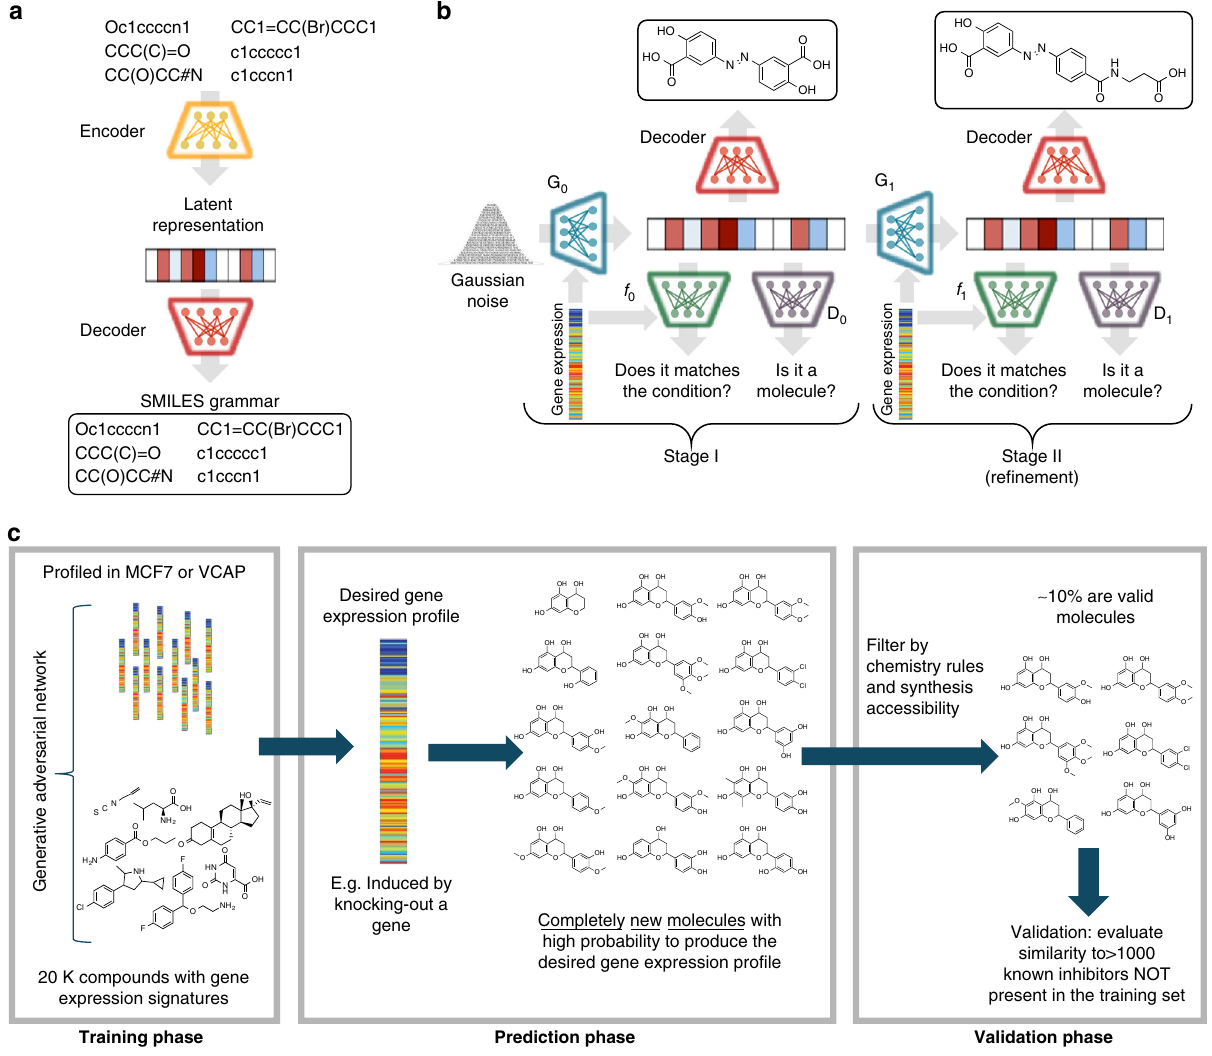
Fig. 1 Graphical representation of the models and pipeline used in the study. Molecules were encoded using a model that transforms the canonical SMILES of a molecule into a latent representation that can be later decoded into the set of grammar production rules needed to reconstruct the original SMILES ( a ). The generative adversarial network in b has a Stage I where the generator ( G 0 in blue) takes the desired gene expression signature together with a vector of random noise to produce a molecular representation that can be decoded into SMILES using the decoder (in red). The discriminator ( D 0 in purple) calculates the probability of the molecular representation to be a real molecule and the conditional network ( f 0 in green) calculates the probability of the molecular representation to match the gene expression signature. In Stage II, the generator ( G 1 in blue) takes as input the desired gene expression signature together with a molecular representation (e.g., the one produced by G 0 ) to repeat the process. The general pipeline is represented in c where the generative adversarial network is trained with ~20 K compounds from the L1000 dataset 25 (see Methods for details) to be able to generate compounds from a desired gene expression signature during the prediction